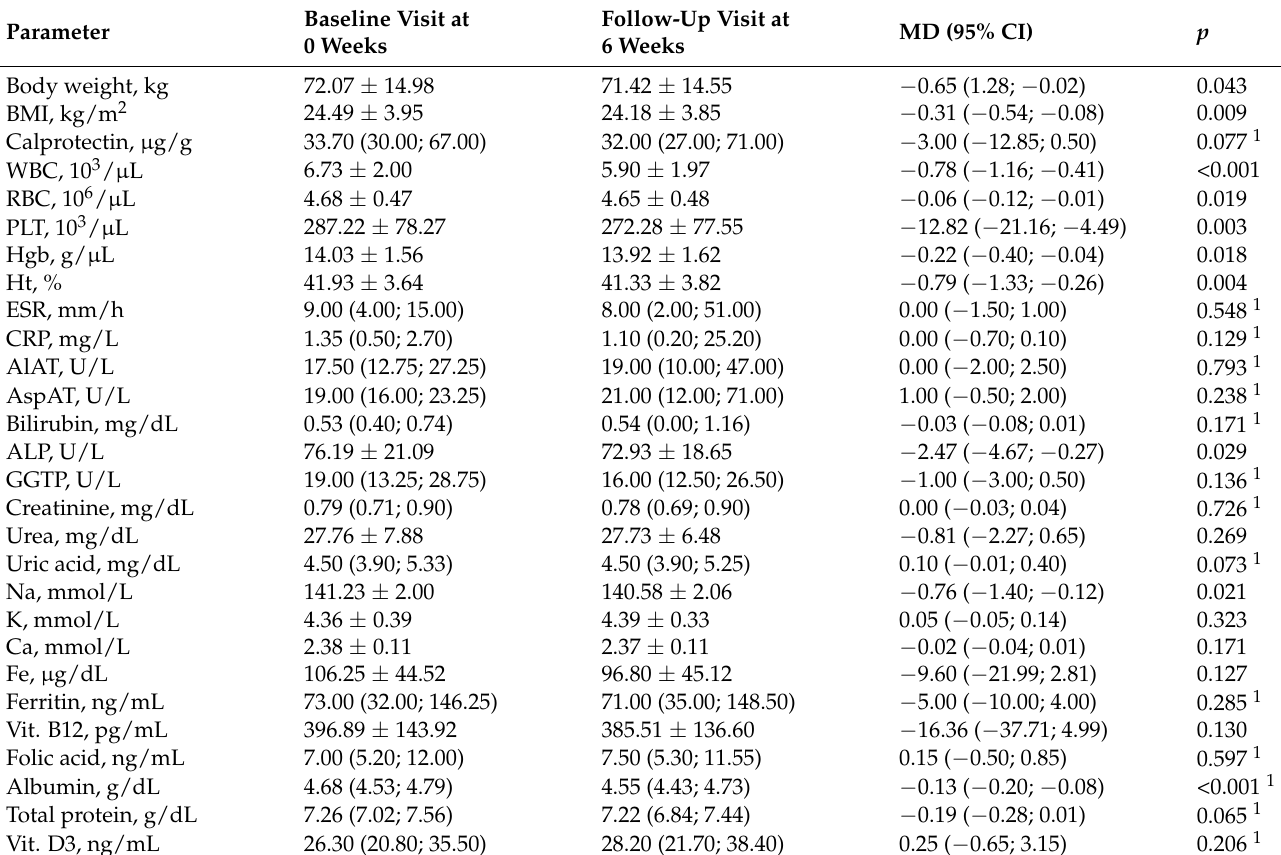
Table 2. Changes in the parameters of IBS patients.